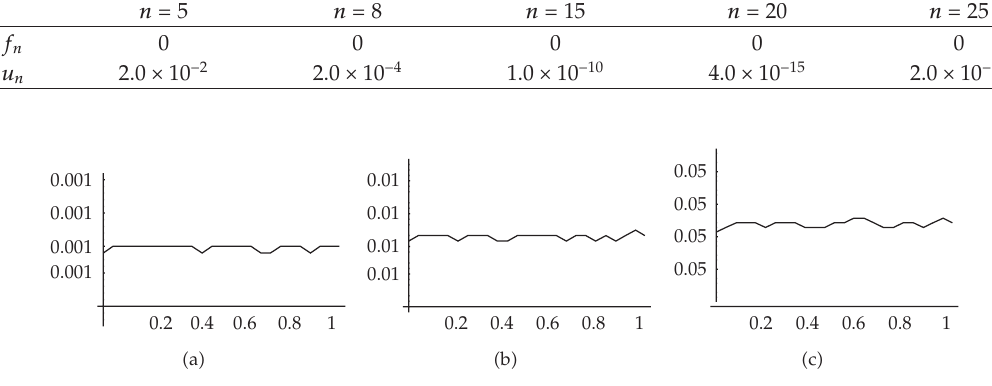
Figure 1: The figure of relative error | (cid:5) f − f 5 (cid:6) /f | with noise σ (cid:4) 0 . 1%, 1%, 5%, respectively, for Example 4.1.